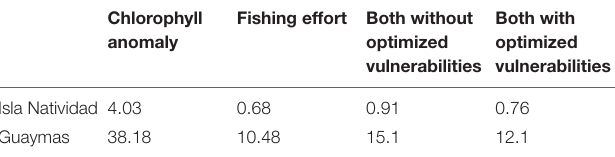
TABLE 3 | Sum of squares (SS) estimated for environmental and fishing drivers during the fitting of the quantitative models of Isla Natividad and